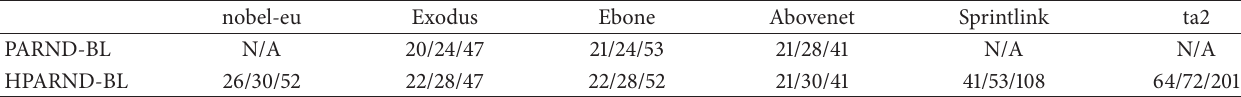
Table 3: Number of powered-on network elements (nodes/links/PICs)—Cubic 𝑃 RP V ,𝑇( V ) , 𝑃 𝐶 V = 200 W. nobel-eu Exodus Ebone Abovenet PARND-BL FGH